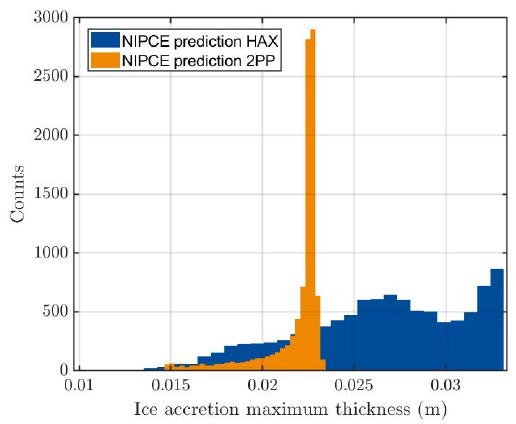
Figure 10. Differences in predicted distributions between the HAX and 2PP models for metamodel M 2 on the 10,000 samples.